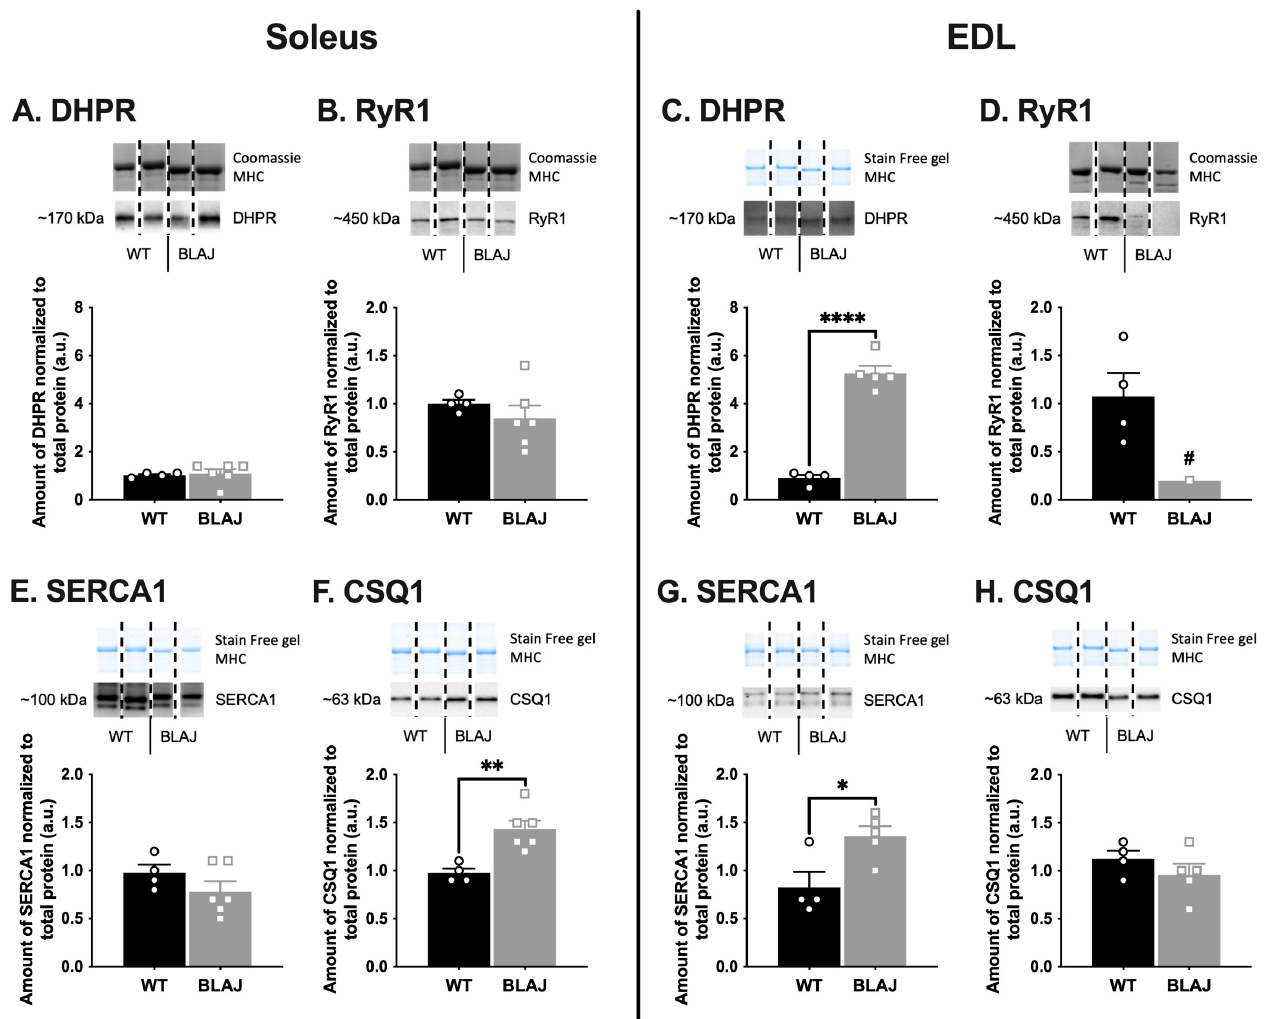
Figure 1. The levels of proteins associated with calcium (Ca 2+ ) handling in soleus and EDL muscles, of WT compared with dysferlin-deficient BLAJ male mice aged 10 months. Whole muscle homogenates analyzed by Western blot. ( A , C ) Dihydropyridine receptor (DHPR); ( B , D ) Ryanodine receptor 1 (RyR1); ( E , G ) Sarco/endoplasmic reticulum Ca 2+ -ATPase 1 (SERCA1); ( F , H ) Calsequestrin 1 (CSQ1). Data analyzed by Student’s t -test: *, **, **** BLAJ vs. WT ( p < 0.05, 0.01, 0.0001, respectively). # RyR1 levels were reduced and undetectable in five of six BLAJ EDL muscles analyzed resulting in n = 1 for this group, hence statistical comparisons were not appropriate to be reported for these data. Data are presented as individual values (WT as circles, BLAJ as squares) and mean ± SEM ( n = 1–6), with representative Western blots where non ‐ contiguous lanes from the same gel are separated by black dashed lines.